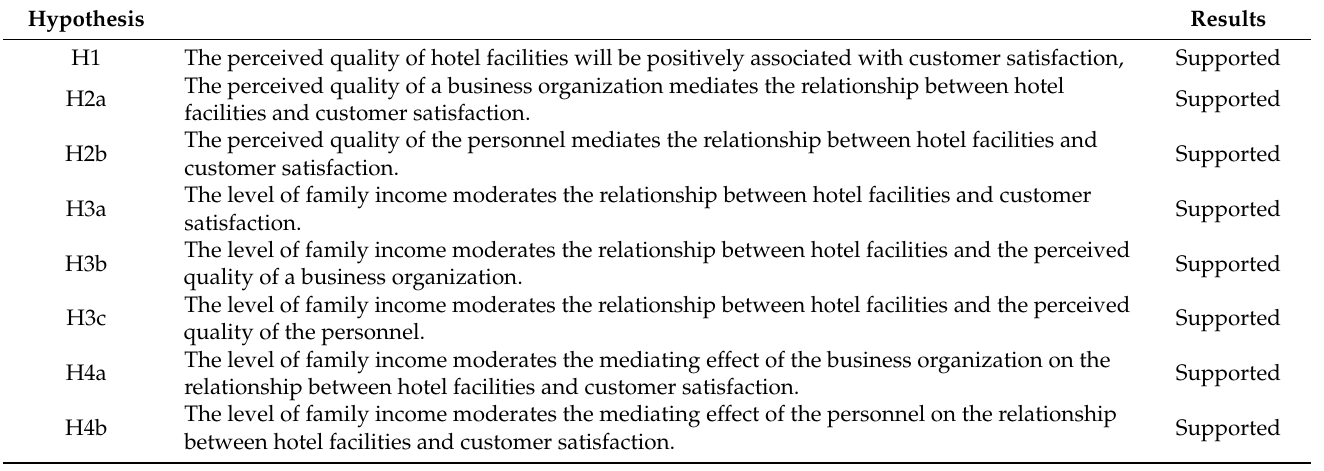
Table 9. Hypothesis